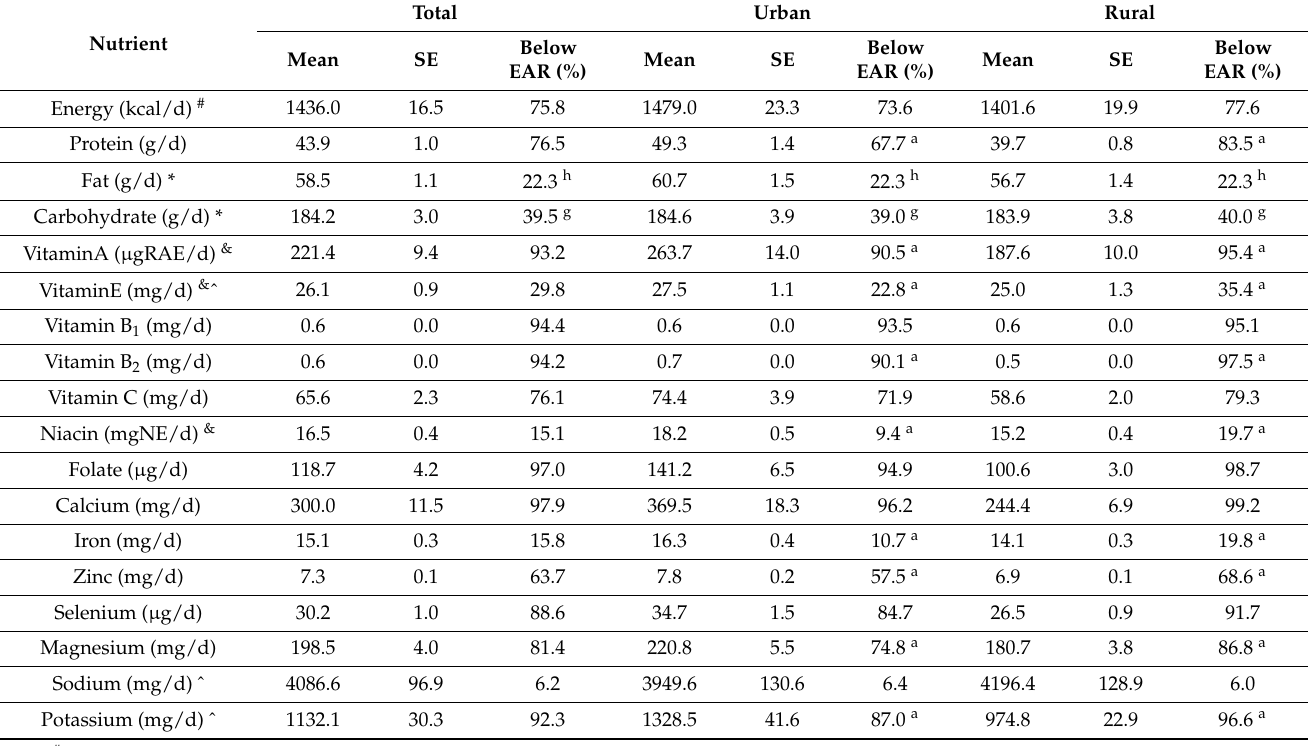
Table 2. Dietary daily intake of energy and nutrients and the prevalence of deficiency in the subjects aged 80 and above in urban and